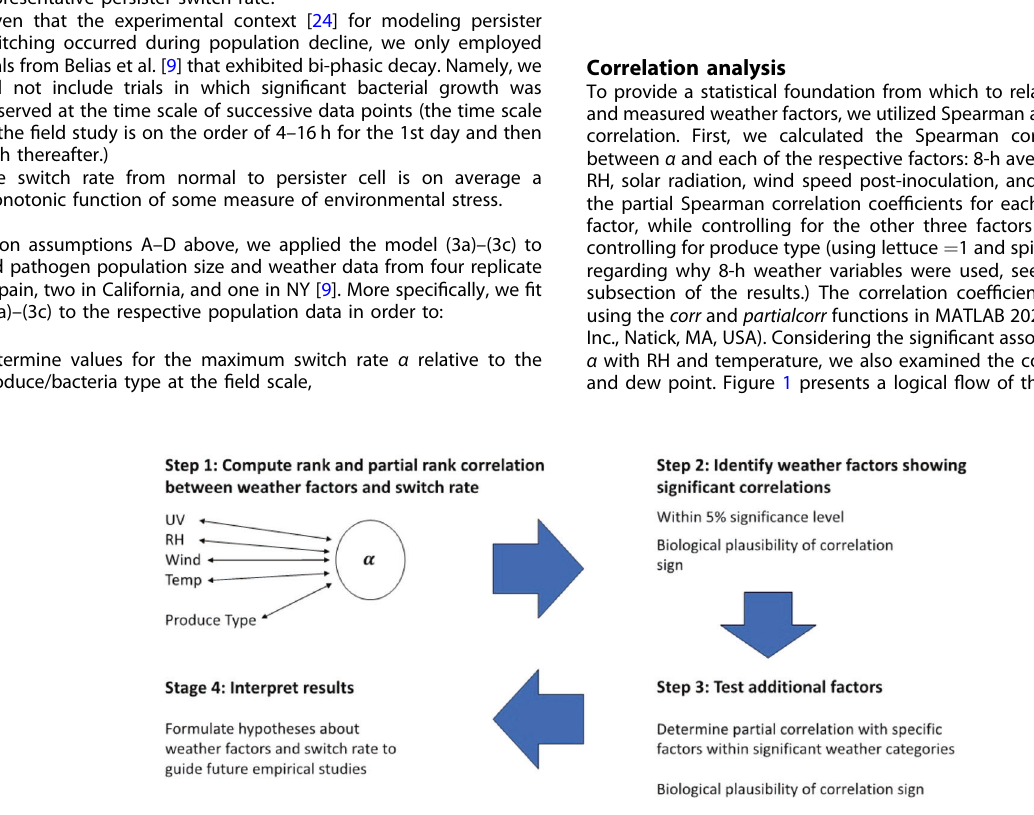
Fig. 1 Logical fl ow diagram for statistical analysis. Factors in Step 1: UV (average ultraviolet radiation intensity), RH (average air relative humidity), Wind (average wind speed), and Temp (average air temperature). All weather data used in the statistical analysis were obtained over 8 h post-inoculation of E. coli and Salmonella onto lettuce and spinach leaves in the fi